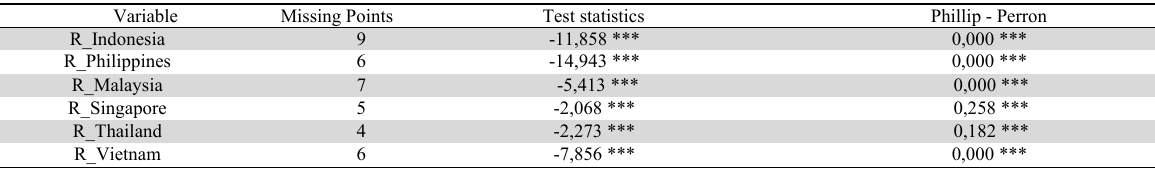
Unit Root Test Variable Missing Points Test